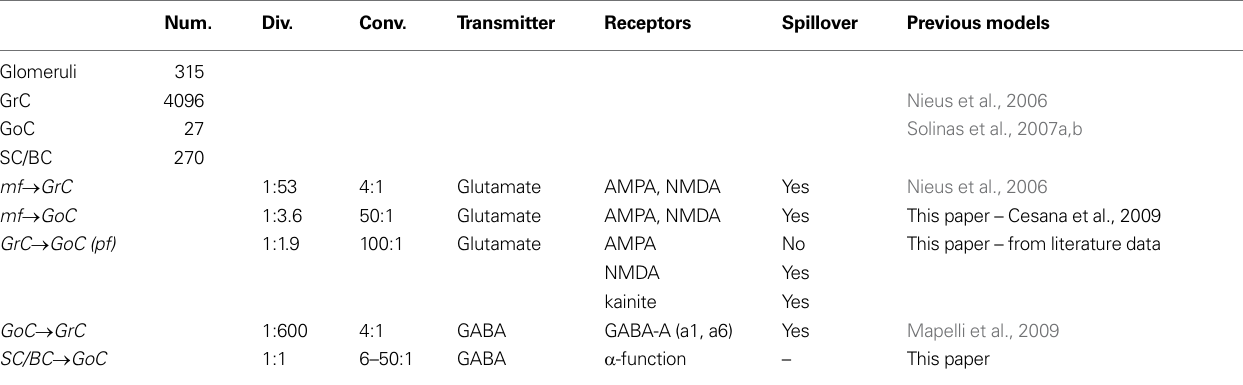
Table 1 | The constitutive elements of the granular layer network. Num. Div.